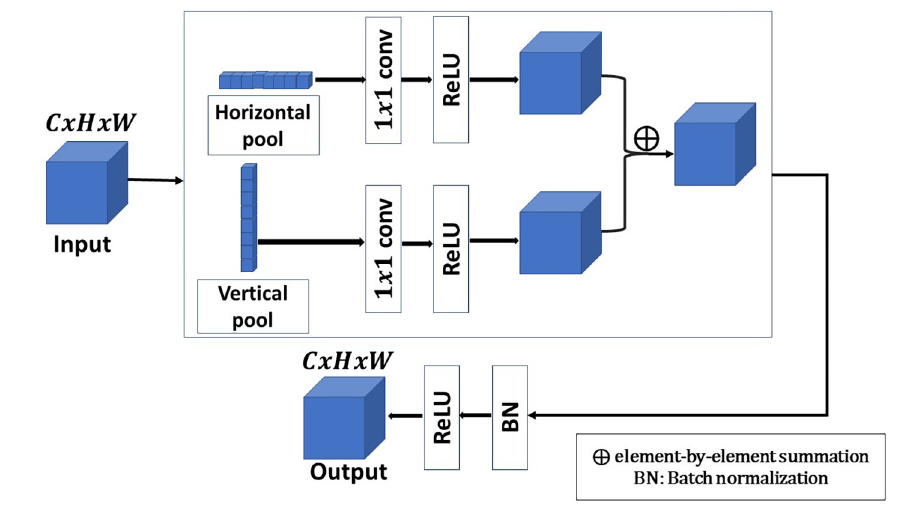
Fig 3. Vector pooling block.